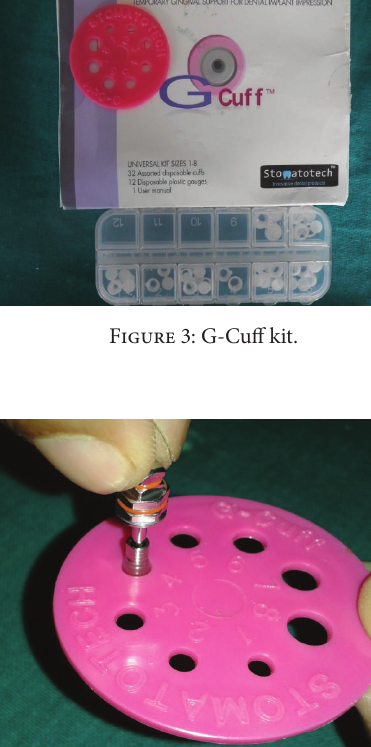
Figure 4: Selection of